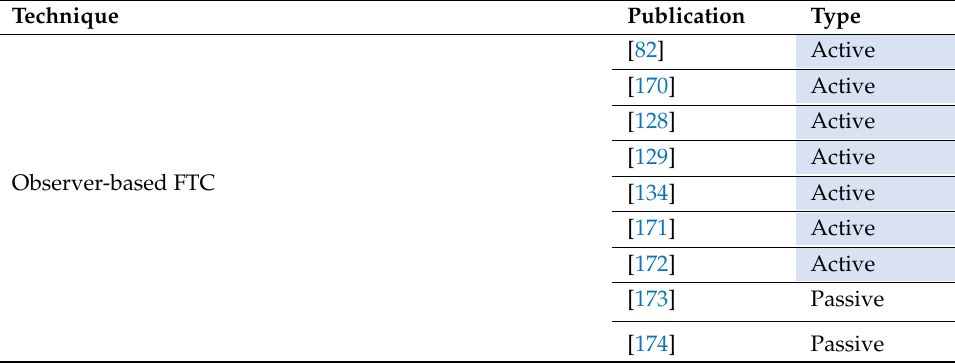
Table 5. Summary of the main FTC approaches for